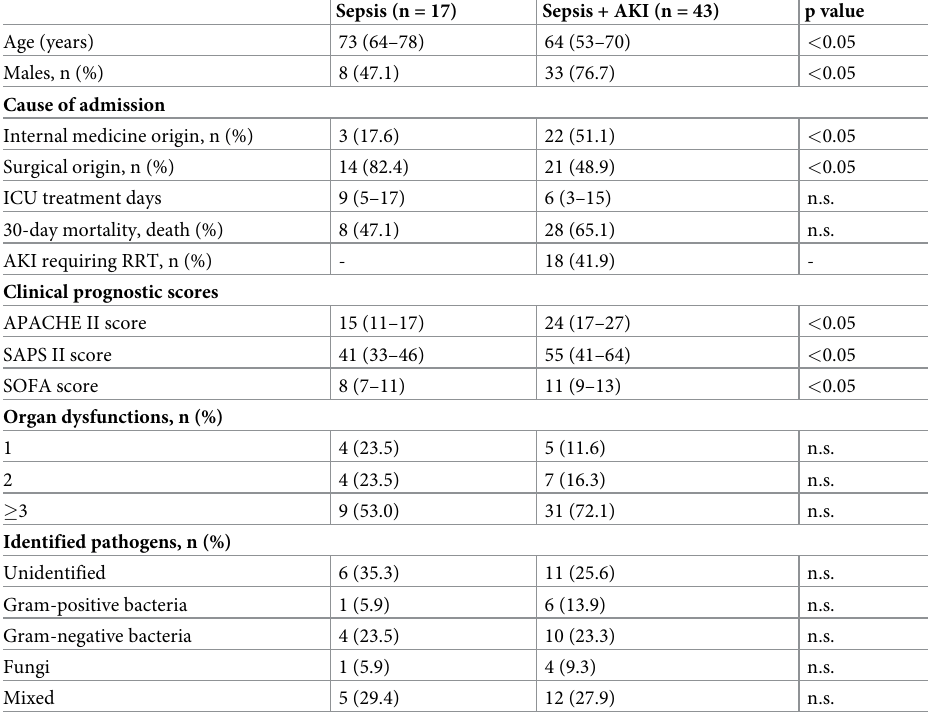
Table 2. Clinical and microbiological data of septic